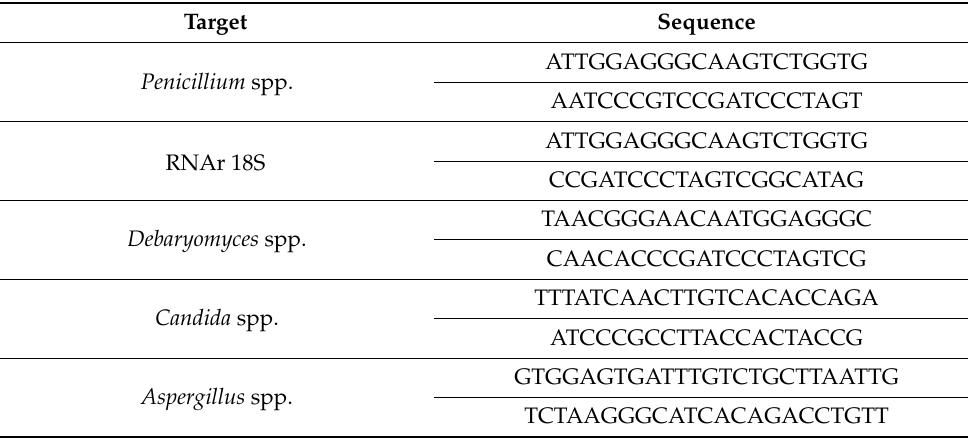
Table 2. Sequences of primers used.